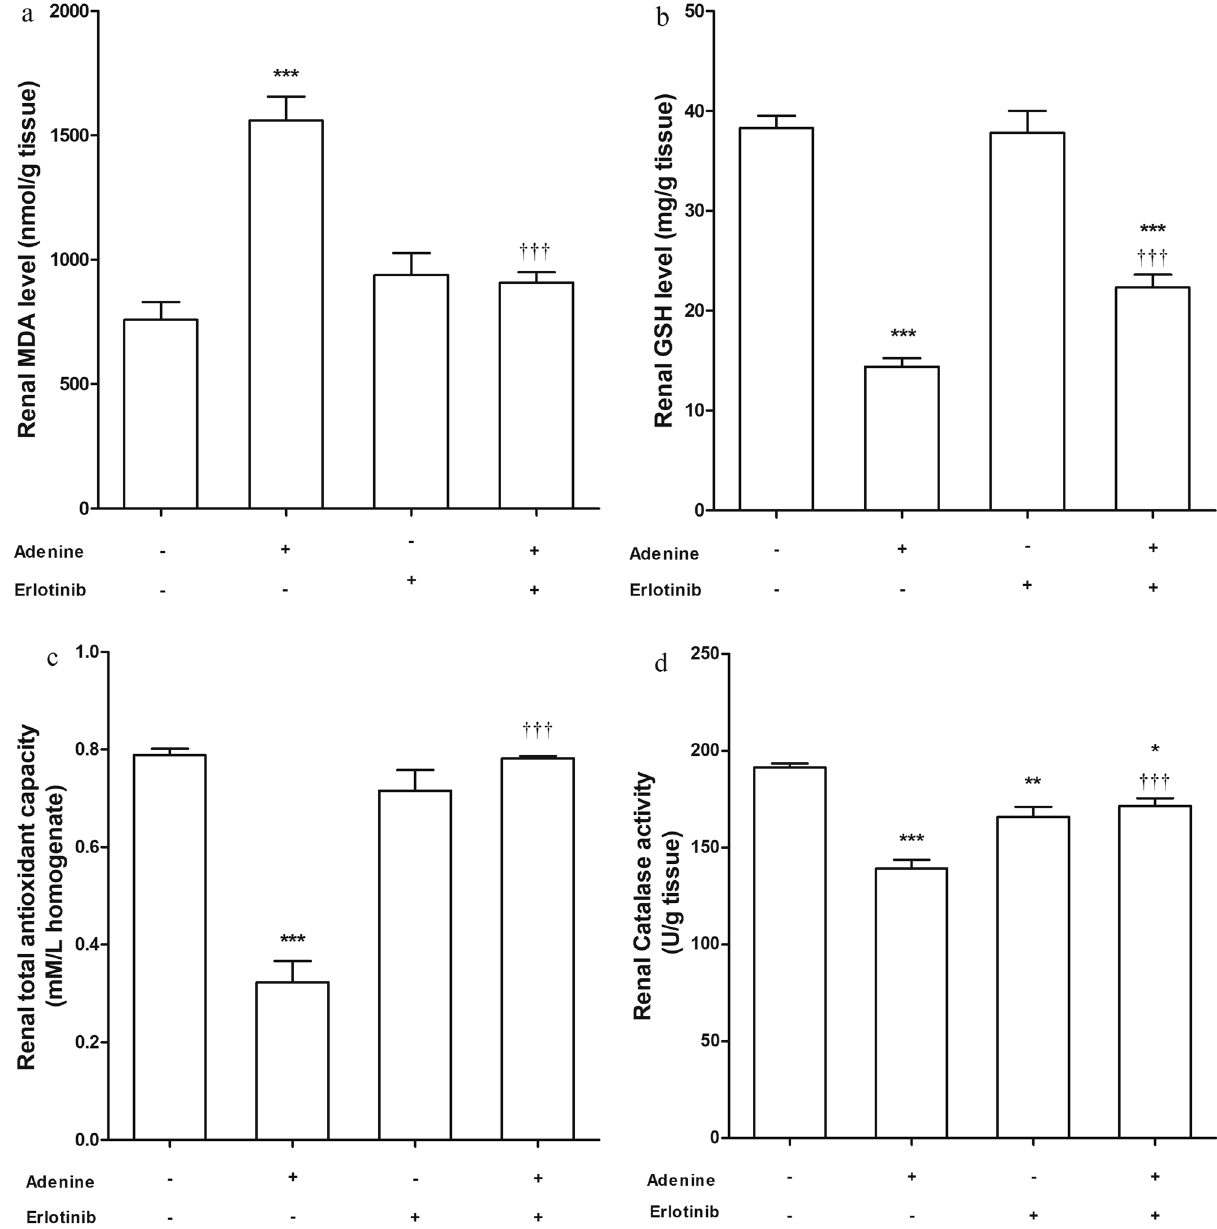
Figure 3. Effect of erlotinib (80 mg/kg) administration on renal ( a ) malondialdehyde (MDA) level, ( b ) reduced glutathione (GSH) level, ( c ) total antioxidant capacity and ( d ) catalase activity in adenine induced nephrotoxicity in mice. Significance: *, **, *** P < 0.05, 0.01, 0.001 compared to control group; ‡‡‡ P < 0.001 compared to adenine